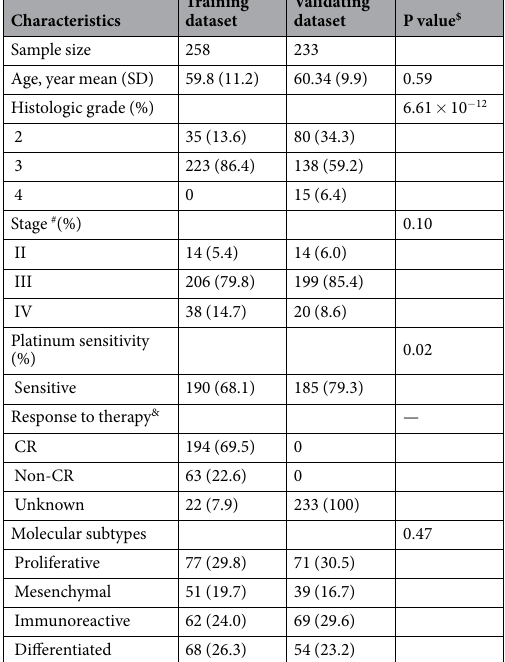
Three datasets with the profiling data of gene expression obtained by using pretreatment biopsies in patients who received platinum-based chemotherapy and corresponding clinical data were downloaded from the GEO database (http://www.ncbi.nlm.nih.gov/geo/). All data were obtained with Affymetrix Human U133 Plus 2.0 arrays (Affymetrix). After the removal of the samples without progression-free